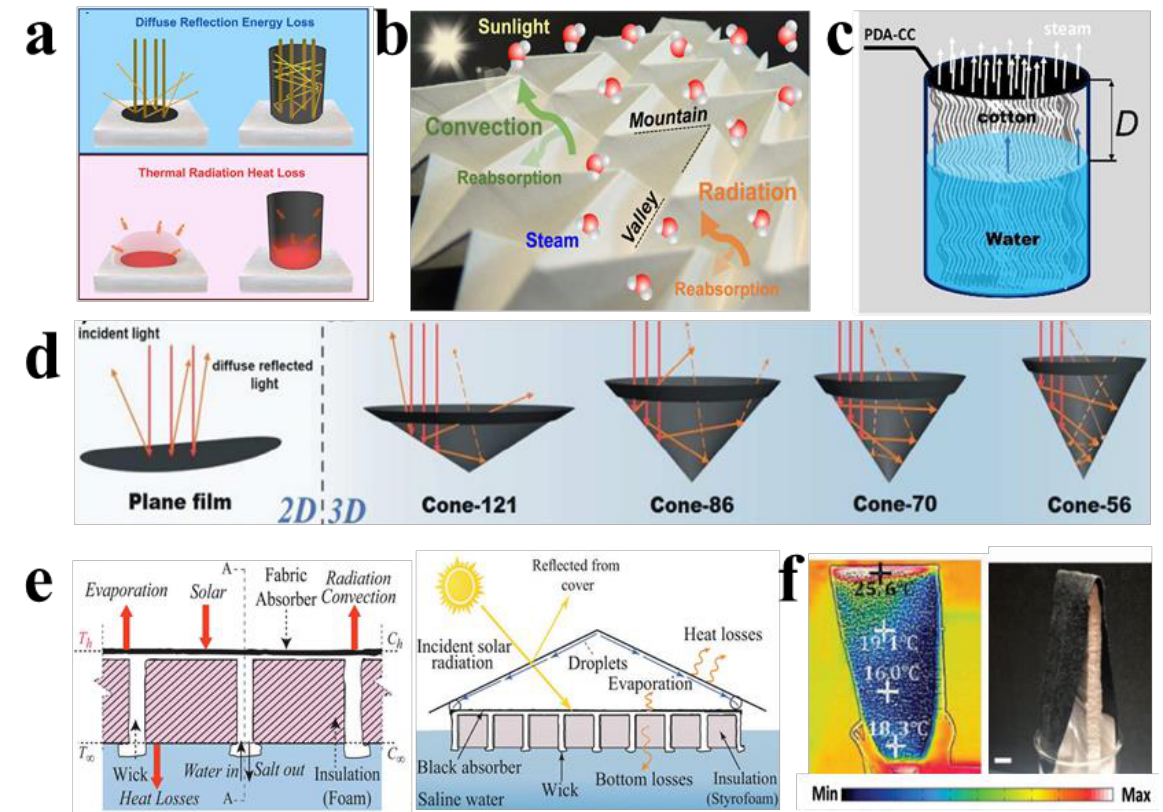
Figure 5: Schematic illustration of 3D structural design of thermal management: (a) 2D disk and 3D cup [111]; (b) Miura-ori tessellation [112]; (c) photothermal cone [113]; (d) lamp-like [95]; (e) salt-rejecting evaporation [108]; (f) CP-air-foam structures and thermal distribution